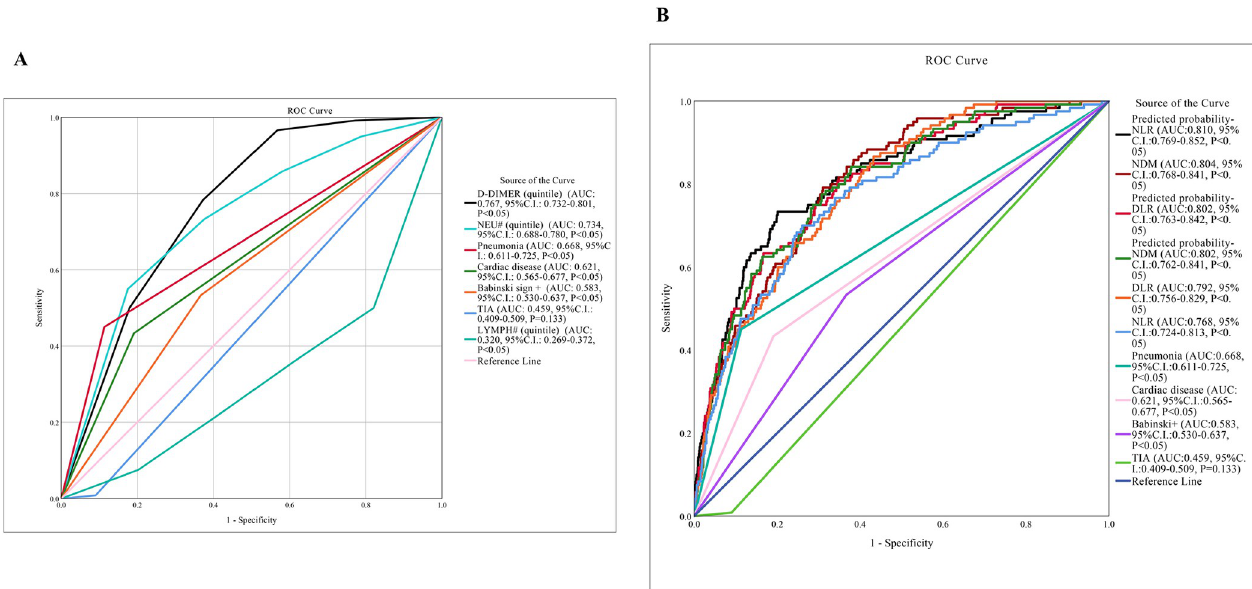
Fig 4. The ROC curves. A: ROC of TIA, Cardiac disease, Pneumonia, Babinski sign +, NEU# (quintile), LYMPH# (quintile), D-DIMER (quintile) to poor prognosis of AIS patients. NEU# (quintile): Neutrophil count in 5 quintiles, LYMPH# (quintile): Lymphocyte count in 5 quintiles, D-DIMER (quintile): D- dimer in 5 quintiles. B: ROC of NLR: The ratio of neutrophil count to lymphocyte count, DLR: The ratio of D-dimer to lymphocyte count, NDM: Neutrophil count multiplied by D-dimer, TIA: Transient Ischemic Attacks, Cardiac disease, Pneumonia, Babinski sign +, Predicted probability-NLR, Predicted probability-DLR, Predicted